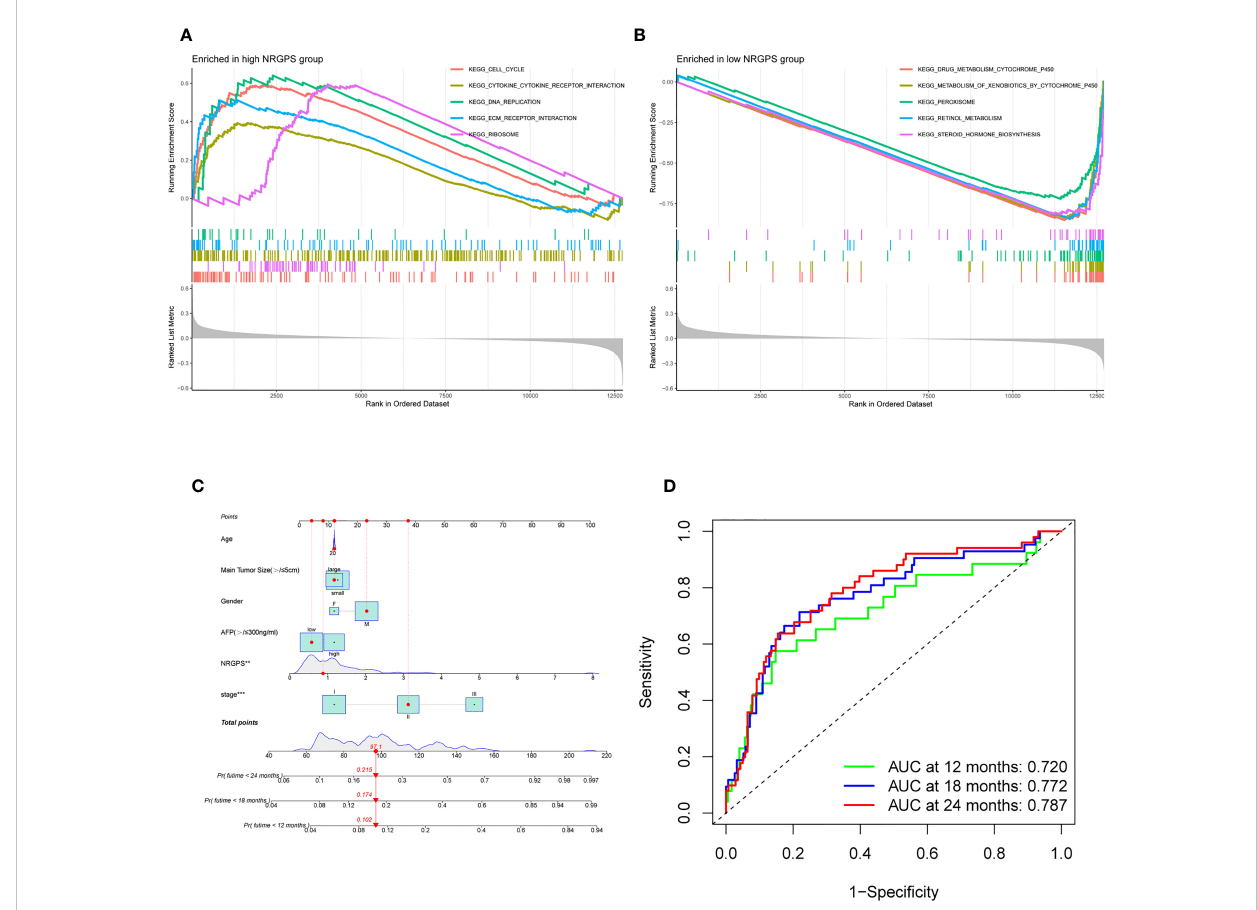
FIGURE 6 GSEA analysis and Nomogram. (A) GSEA in the high-NRGPS group. (B) GSEA in the low-NGPS group. (C) Nomogram. (D) The ROC curve of